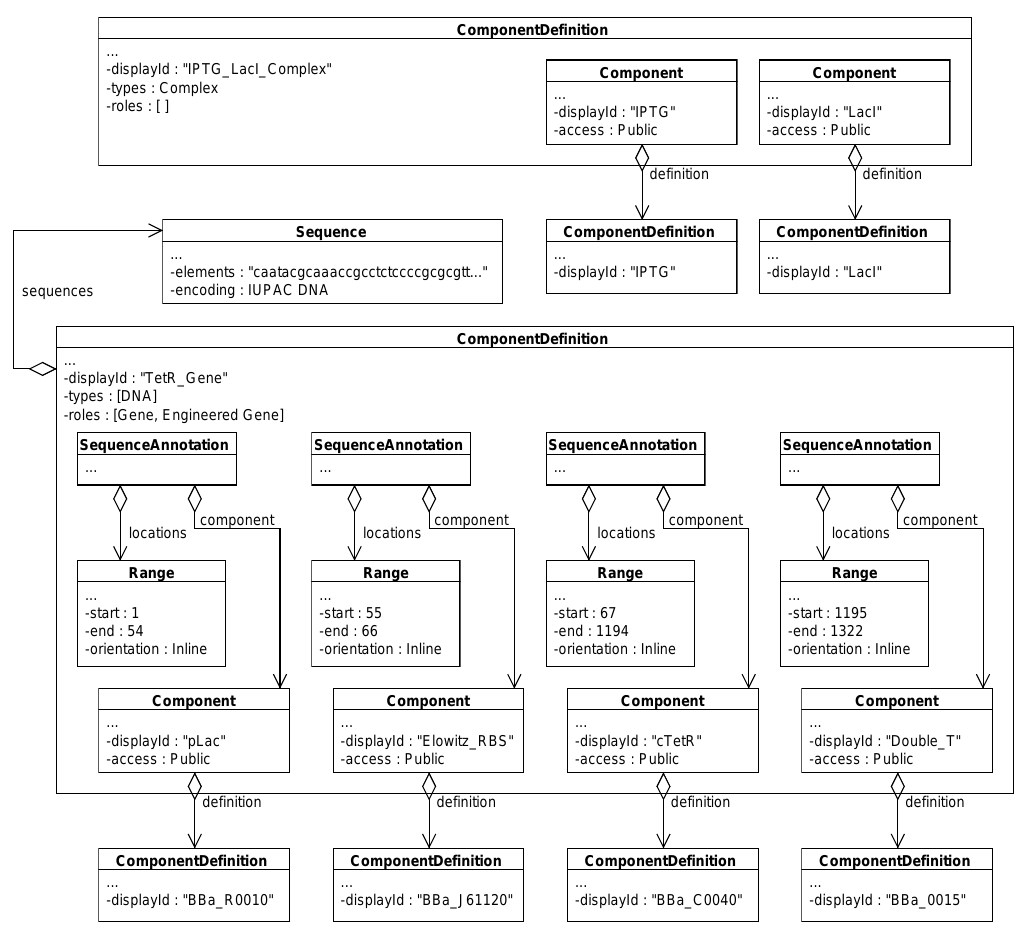
Figure 26: Composite ComponentDefinition objects for the LacI inverter. In the case of the ComponentDefinition that represents the TetR gene, its sub- Component objects are located as Range s along its Sequence using SequenceAnnotation objects. The ComponentDefinition that represents the IPTG-LacI complex, however, has no Sequence and its sub- Component objects are composed without any data about their relative positions.